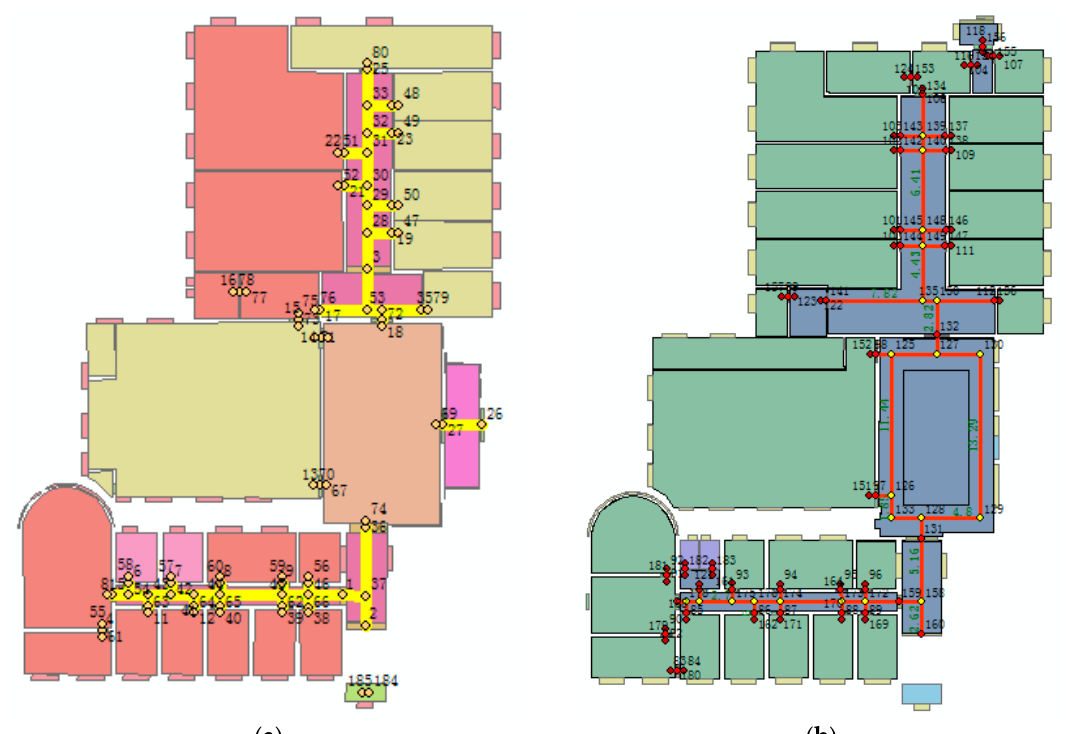
Figure 4. The route network extracted from a floorplan: ( a ) the second floor; and ( b ) the third floor. The corridors (represented with the red lines) are the middle skeleton lines with orientation constraint. The rooms (brown points) are represented by points with range buffers. The open areas (multiple brown points) are the same as the rooms, while implicitly having an orientation constraint of eight neighbors. The stairs connect two floors with a range of the starting point and the end point corresponding to the two floors. The yellow points on the edges define the locations facing a choice of turning into the room or walking along the corridor. The red points represent the doors connecting the rooms and the corridors or transitions connecting two floors.